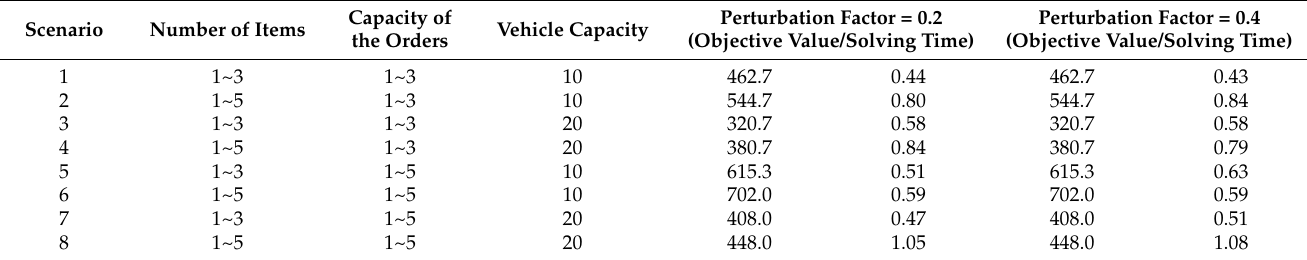
Table 7. Average computation time under different perturbation factors (unit: